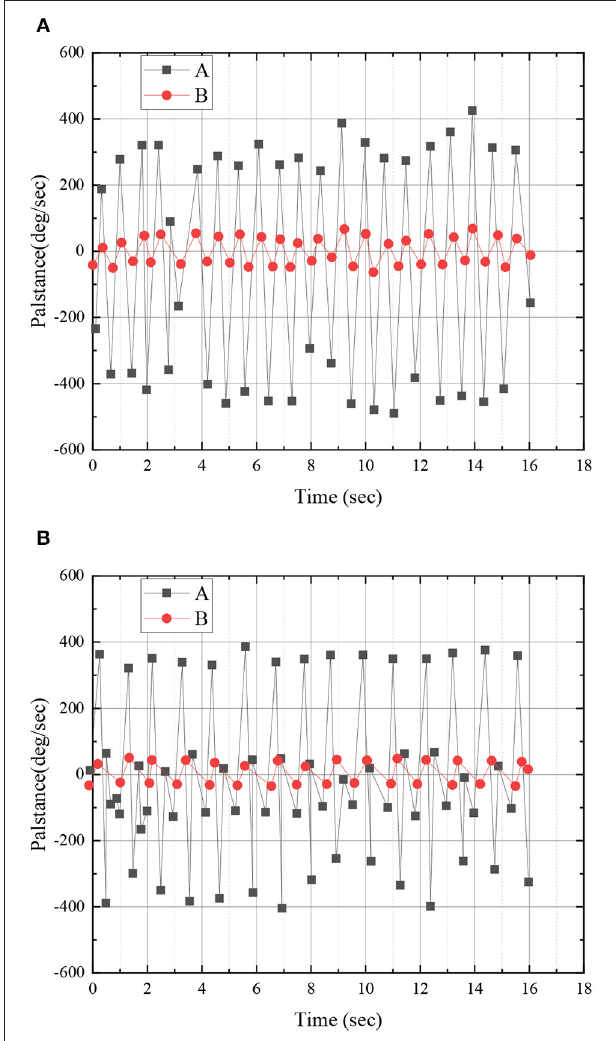
FIGURE 8 | Comparison of the angles and angular velocities of basketball players forearm dribbling and calf walking: (A) forearm and (B) calf. (A: forearm/calf angular momentum while dribbling and B: forearm/calf angle while